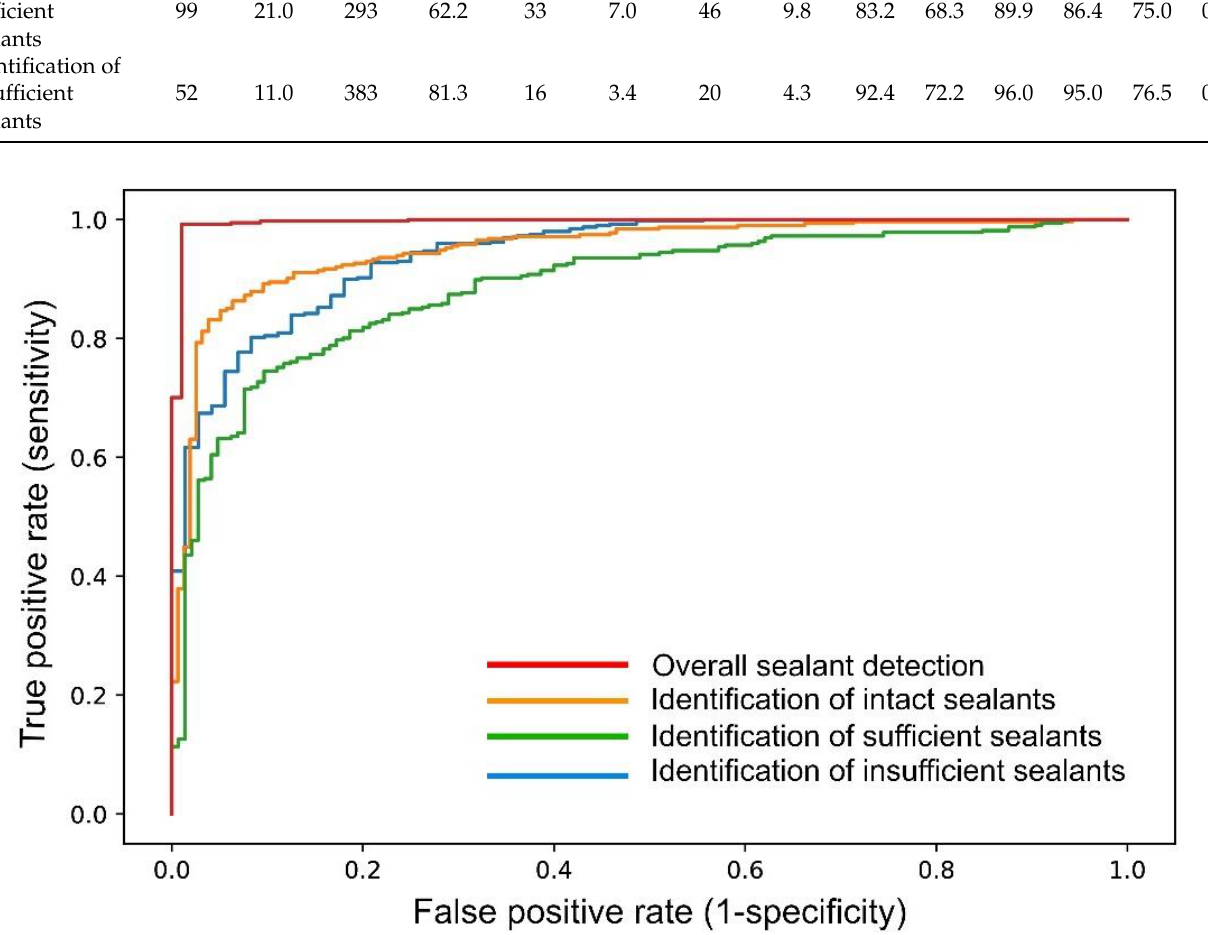
Figure 2. The ROC curves illustrate the model performance of the developed CNN for overall and categorical sealant detection.